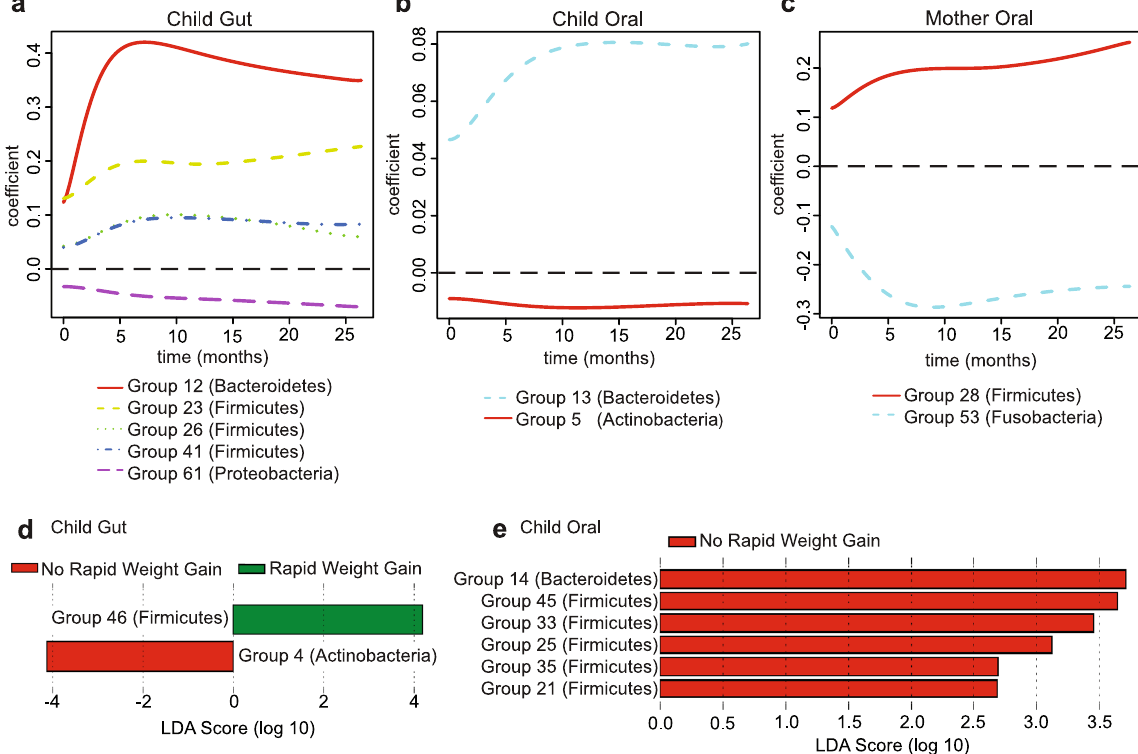
Figure 4. Identification of influential taxonomic groups. Estimated regression coefficient curves for taxonomic groups affecting growth curves, as identified by FLAME 66 in (a) children’s gut microbiota, (b) children’s oral microbiota, (c) mothers’ oral microbiota. The zero line (dashed) corresponds to no effect. Linear Discriminant Analysis scores for taxonomic groups distinguishing children with rapid vs. non-rapid infant weight gain, as identified by LEfSe 67 in (d) children’s gut microbiota, (e) children’s oral microbiota. See Supplementary Table S8 for a list of genera belonging to each group identified by FLAME and